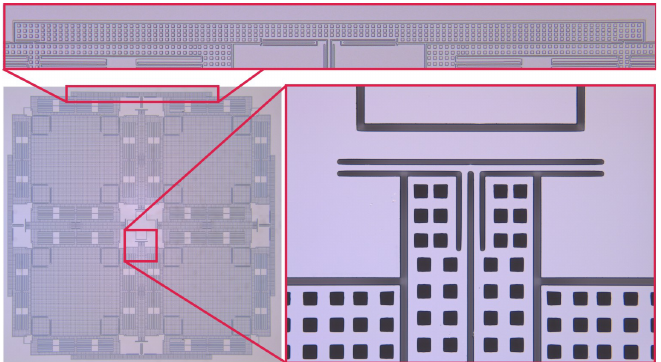
Figure 4. Four external lever mechanisms and four pairs of internal secondary beam resonators, responsible for ordering the eight vibrational modes of a QMG and for placing the desired anti-phase mode at the lowest frequency